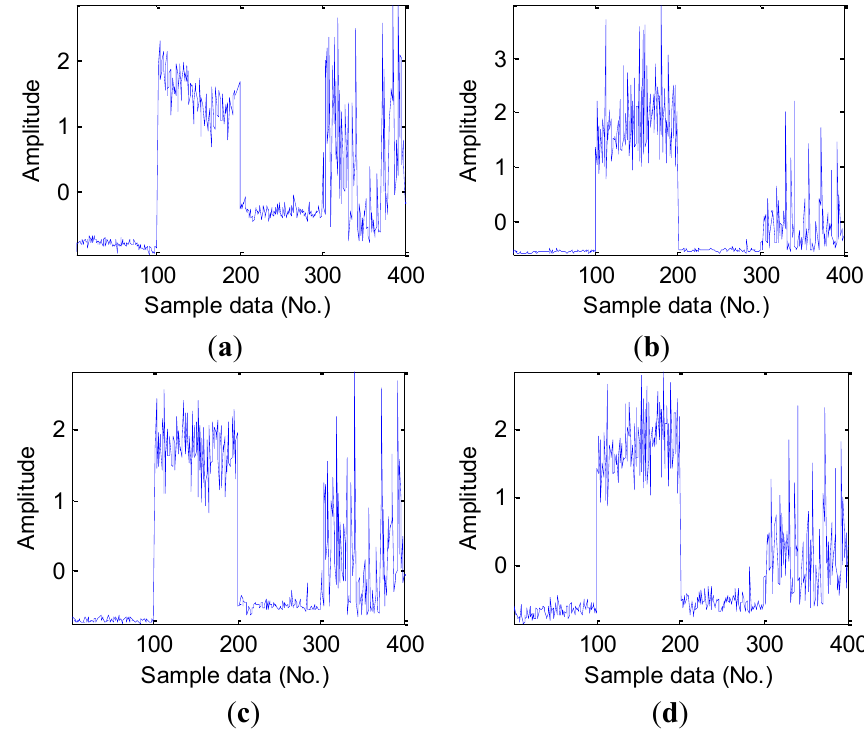
Figure 5. The normalized time domain features in the D_MIX dataset: ( a ) RMS. ( b ) kurtosis value. ( c ) peak-peak value. ( d ) impulse factor. (Note: Sample data No. 1–100, 101–200, 201–300,301–400 represent Normal, IRF14, ORF14 and BF14, respectively).